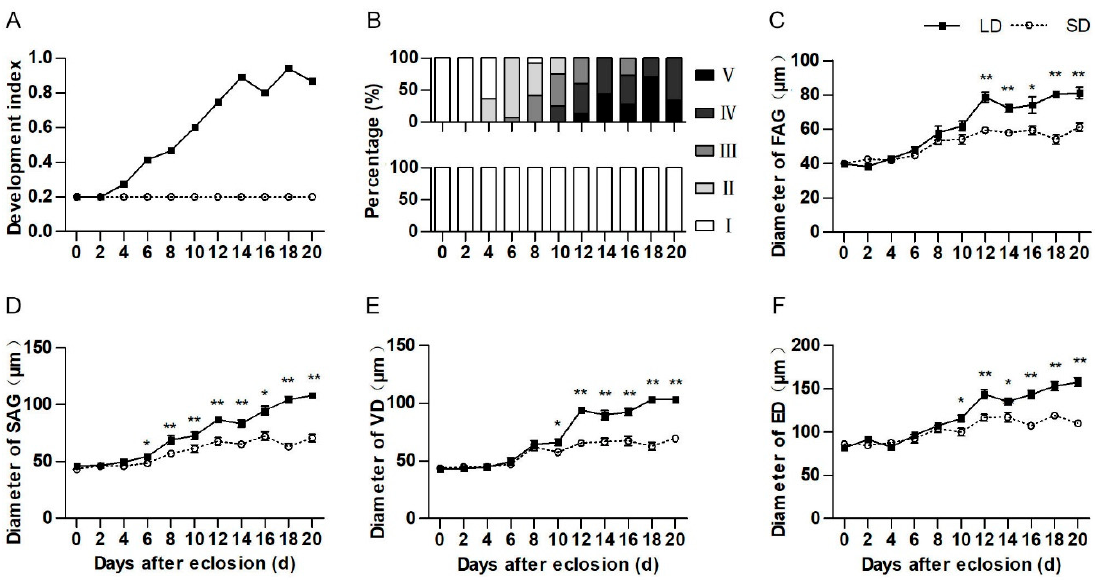
Figure 2. Di ff erences in the development of internal reproductive organs in pre-diapause and pre-reproductive adult H. axyridis . ( A ) Developmental trajectory of the ovary in pre-reproductive (LD) beetles reared under a long-day condition and pre-diapause (SD) beetles reared under a short day condition, ( B ) changes in ovarian development during di ff erent developmental stages (I–V) in pre-diapause (upper) and pre-reproductive (lower) beetles, ( C – F ) developmental trajectory of the first accessory gland (FAG), second accessory gland (SAG), vas deferens (VD), and ejaculatory duct (ED), in pre-reproductive (LD) and pre-diapause (SD) beetles. All values are means ± standard error. Values in (A) and (B) were estimated from 15 independent biological replicates. Values in ( C – F ) were estimated from 10 independent biological replicates. Asterisks indicate significant di ff erences determined by an independent samples t -test (* p < 0.05, ** p < 0.01).